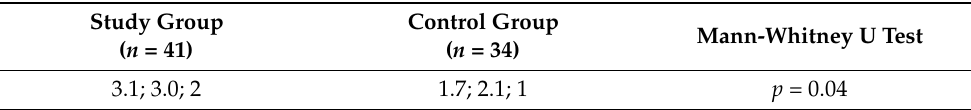
Table 16. Parent’s self-efficacy scale on using devices during family mealtimes (provided in: mean; standard deviation; median) (question A/11).